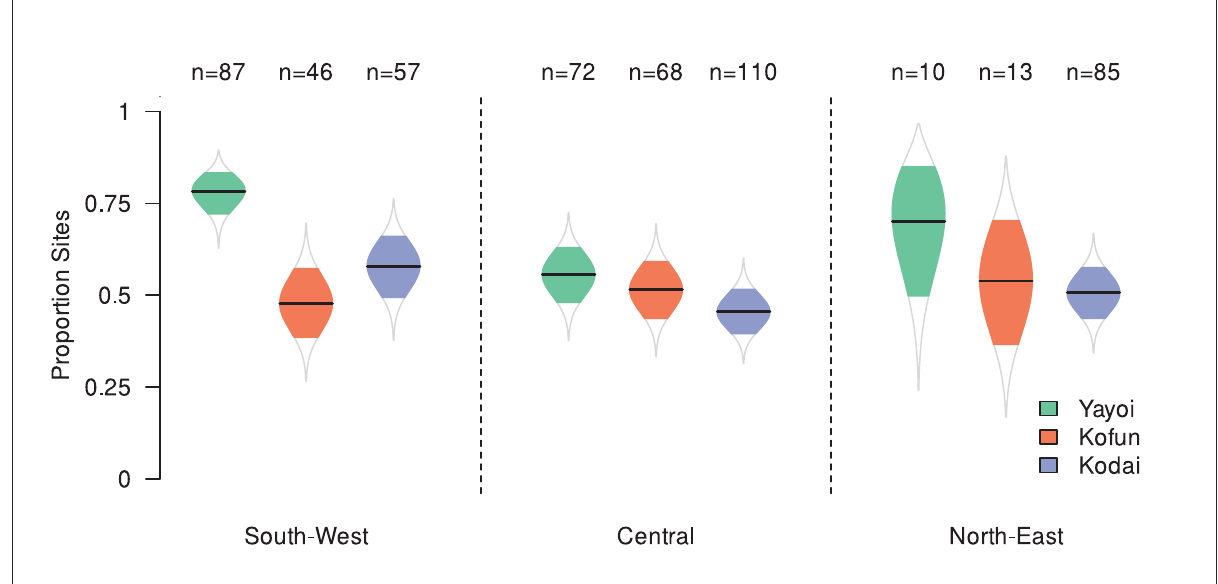
FIGURE4 Posterior probability distribution of archaeological sites with crop remains (rice and/or millet) yielding wild nuts in different regions of Japan (excluding Hokkaido and Okinawa) in Yayoi, Kofun, and Kodai periods. Horizontal bars indicate the observed proportion whilst the highlighted regions represent the 90% Jeffreys interval. South-West (Kyushu, Chugoku, Shikoku, Kansai); Central (Chubum Kanto); North-East (Tohoku) (Data from Database of Plant Macrofossils from Archaeological Sites in Japan, Ishida et al.,